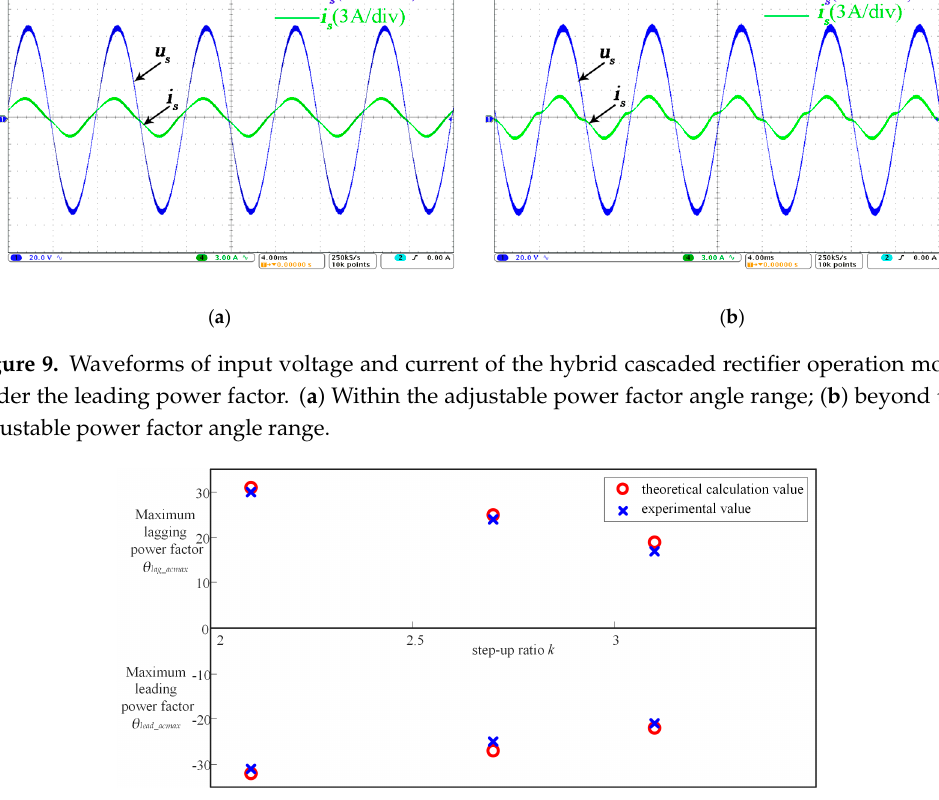
Figure 10. Maximum adjustable power factor comparison between the theoretical calculation values and experimental values under di ff erent step-up ratio k